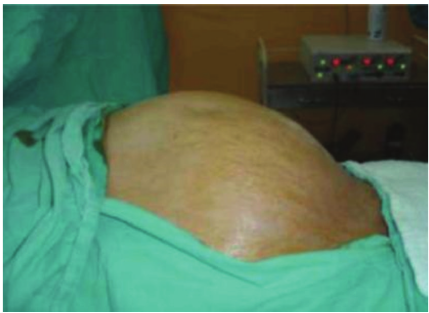
Figure 3: Macroscopic view of the left kidney.